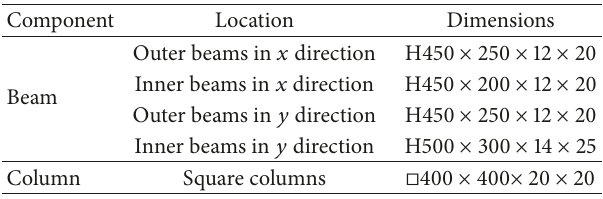
Table 1: Configurations and dimensions of the beam and column